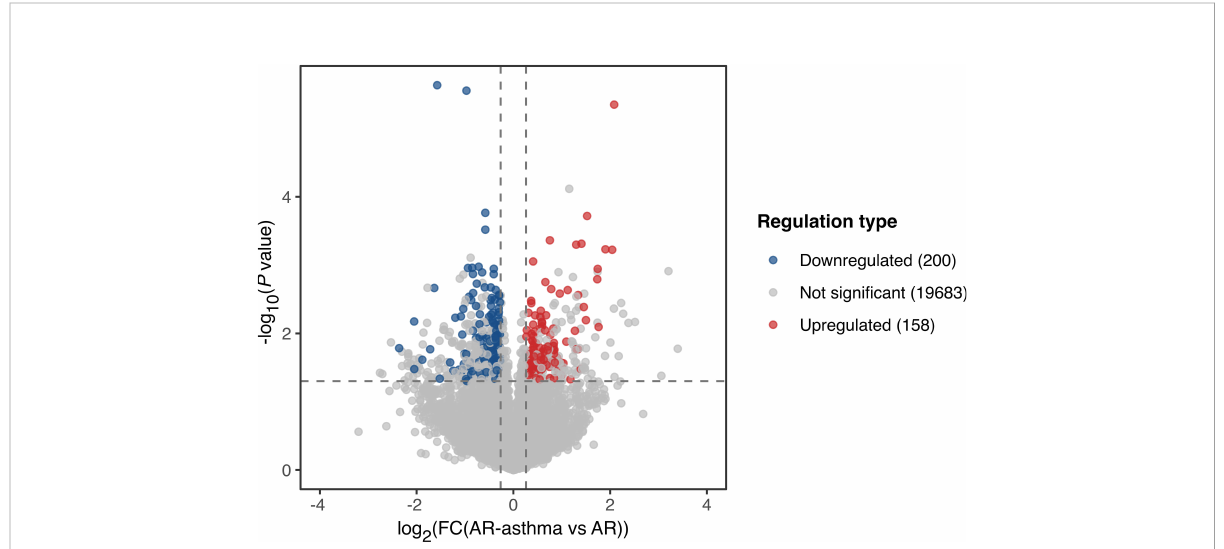
FIGURE 1 Volcano plot showing DEGs of the AR-asthma group compared to the AR group during the pollen season. Signi fi cantly up- and down-regulated genes (|fold change| ≥ 1.2, P value < 0.05 and average FPKM, fragments per kilobase of transcript per million fragments mapped ≥ 1) were labeled as red and blue dots, respectively. AR, allergic rhinitis; DEGs, differentially expressed genes; FC, fold